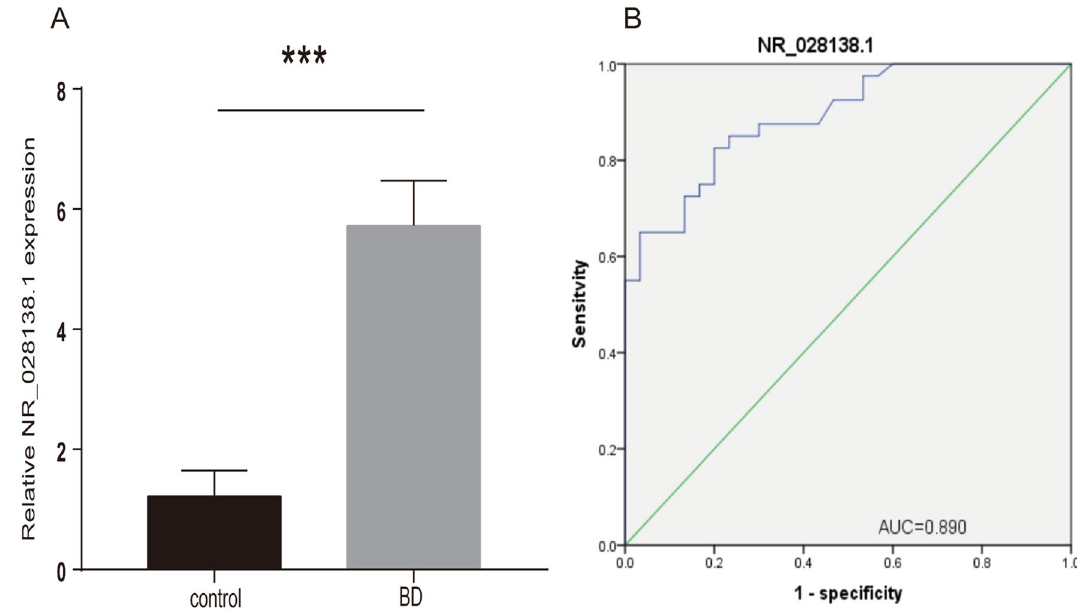
Figure 7. Second qRT-PCR validation of the data on NR_028138.1. ( A ) Relative expression levels of NR_028138.1. Black stars represent significant differences. ( B ) ROC analysis of an NR_028138.1-related model. AUC area under the